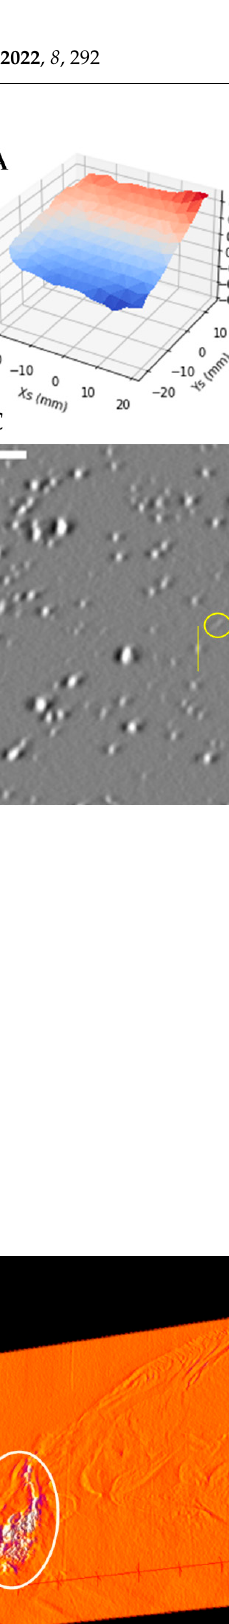
Figure 6. ( A ) is the reconstructed 3D stack of a paraffin-embedded mouse heart sample including an aorta segment. The white oval highlights a calcified lesion in the aorta. ( B , C ) are magnified views